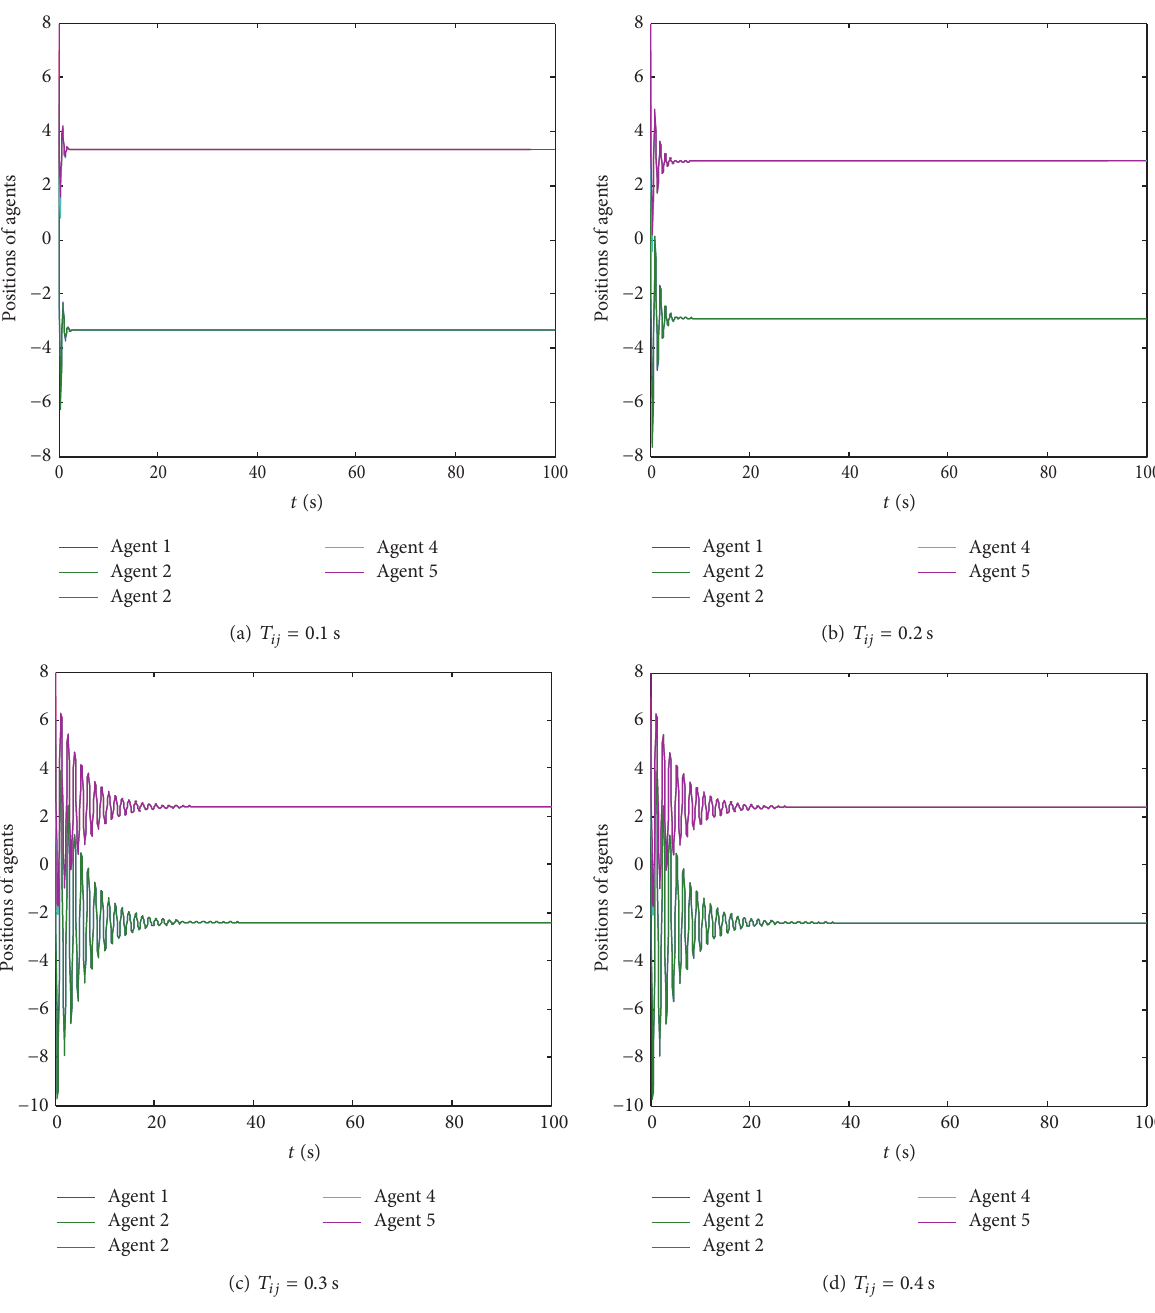
Figure 2: State trajectories of the agents in the networks (5) with